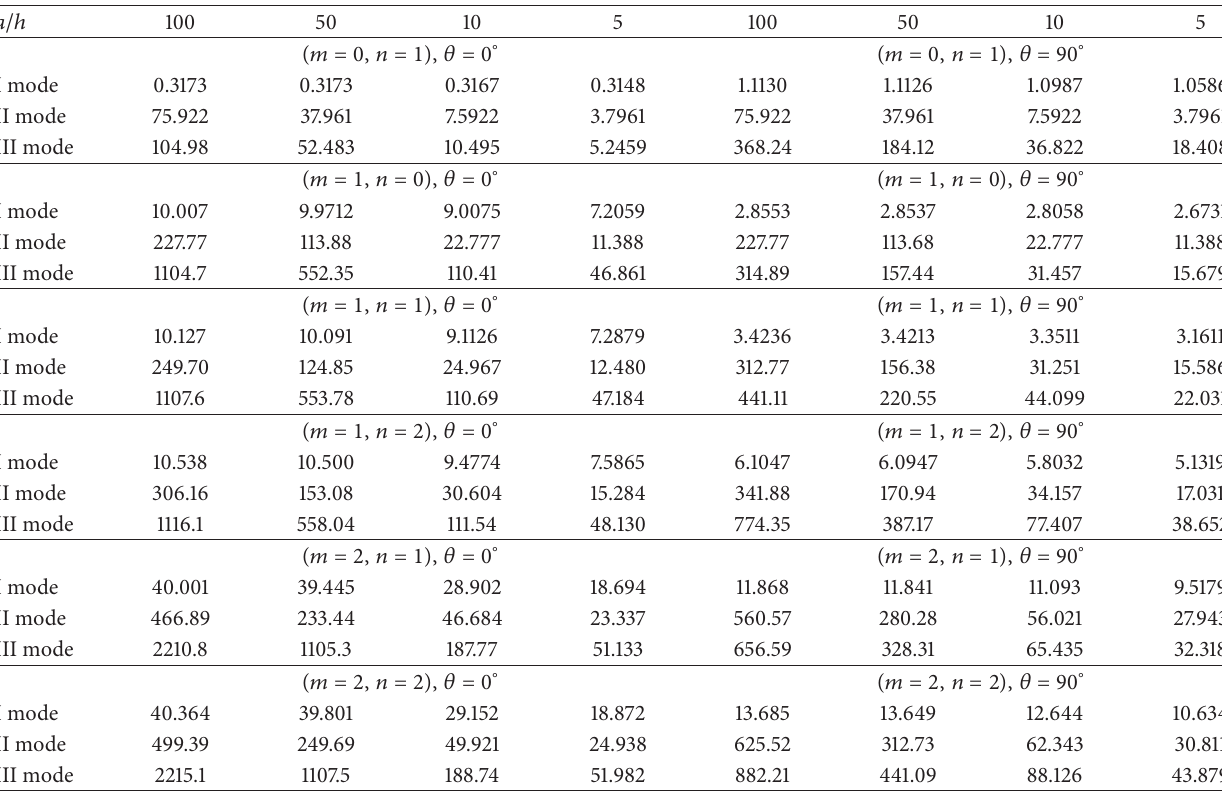
Table 8: Benchmark 4. Simply supported orthotropic rectangular plate. First three vibration modes in terms of no-dimensional circular frequency 𝜔 = 𝜔(𝑎 2 /ℎ)√𝜌/𝐸 2 for several combinations of half-wave numbers 𝑚 and 𝑛 . 𝑀 = 1 fictitious layers and 𝑁 = 18 order of expansion for the exponential